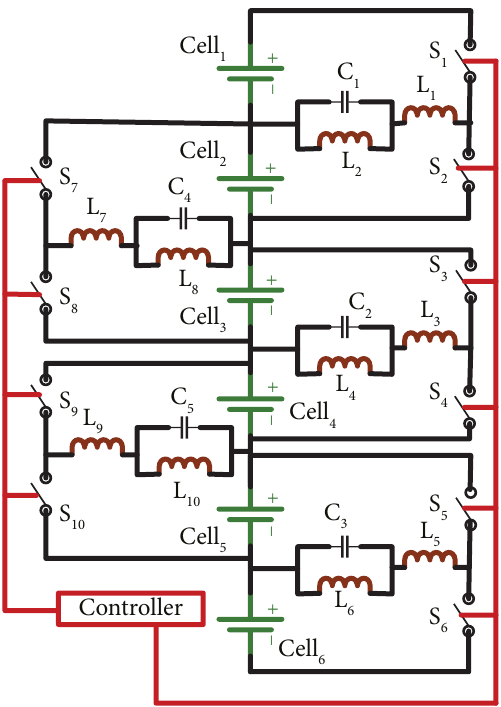
Figure 9: Ramp converter-based BCE.